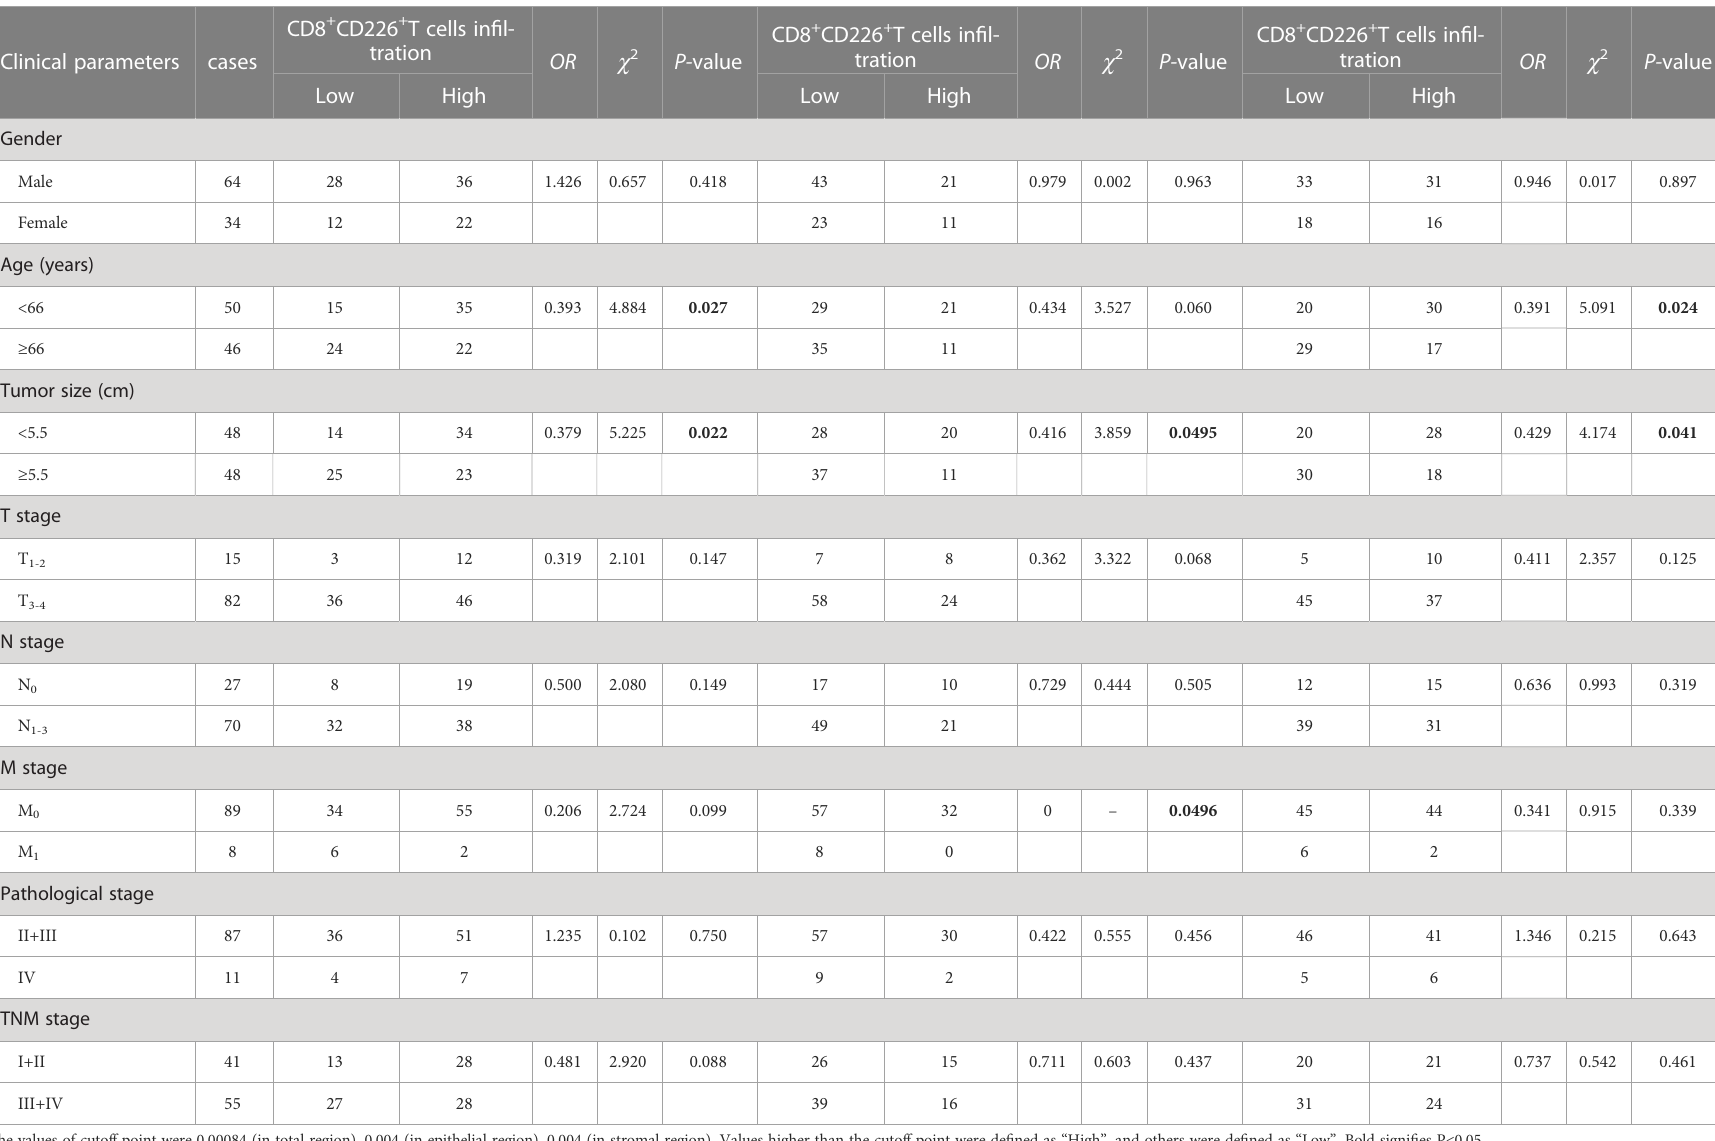
TABLE 3 The association between the percentages of CD8 + CD226 + T cells, CD8 + CD226 + T cells in the epithelial cell region, and CD8 + CD226 + T cells in the stromal cell region in tumor and clinical features of GC patients.